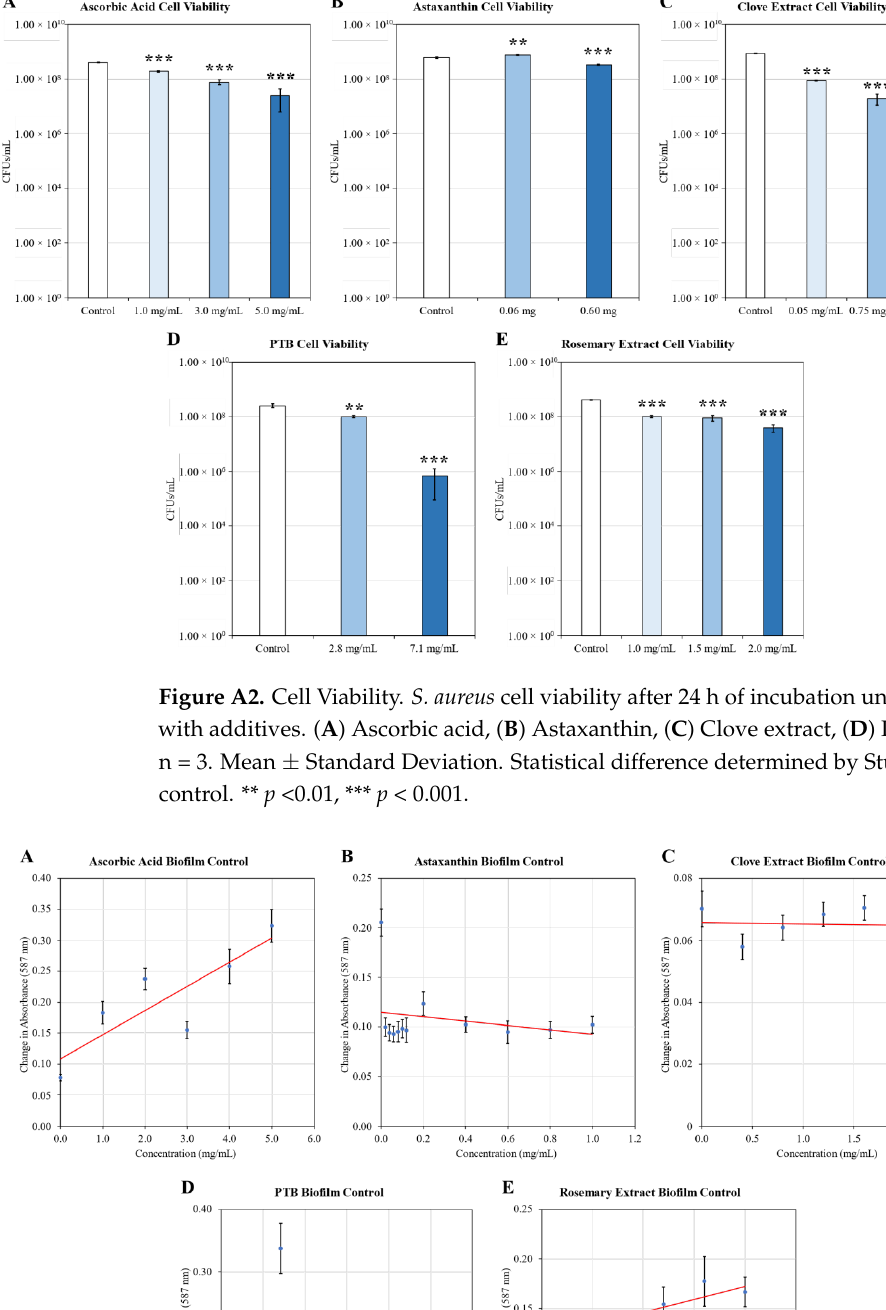
Figure A1. Biofilm Inhibition Logistic Regression. Effect of test compounds on S. aureus biofilm for- mation provoked by 0.5 mg/mL of glucose-keratin. ( A ) Ascorbic acid, R 2 = 0.99. ( B ) Astaxanthin, R 2 = 0.96. ( C ) Clove extract, R 2 = 0.99. ( D ) PTB, R 2 = 0.96. ( E ) Rosemary extract, R 2 = 0.94. Biofilm assayed after 48 h of growth under static conditions. n = 8. Mean ± standard deviation. Logistic regression analysis performed using the dose–response curve package in R.